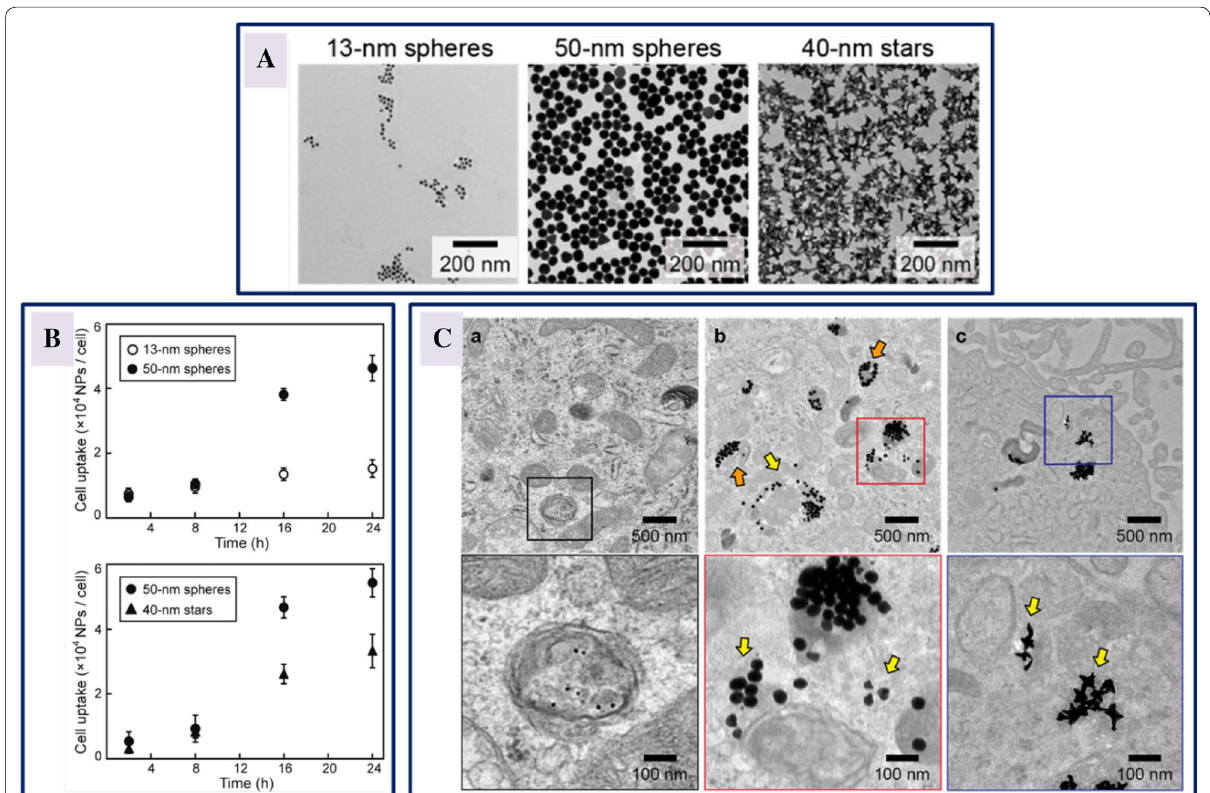
Fig. 5 Cellular uptake of gold nanoconstructs by U87 glioblastoma cells. A Transmission electron micrographs of Au nanoparticles displaying 13 nm spheres, 50 nm spheres and 40 nm stars; B cellular uptake kinetics of Au nanoparticles-siRNA constructs by cells showing size and shape dependent uptake; C transmission electron images illustrating the process of cellular uptake after treatment with 0.5 nM of Au nanoparticles-siRNA constructs for 24 h. The vesicle membranes disrupted by the treatment with 50 nm spheres is signified by orange arrows, and the nanoconstructs distributed outside the vesicles is represented by yellow arrows (reproduced with permission from